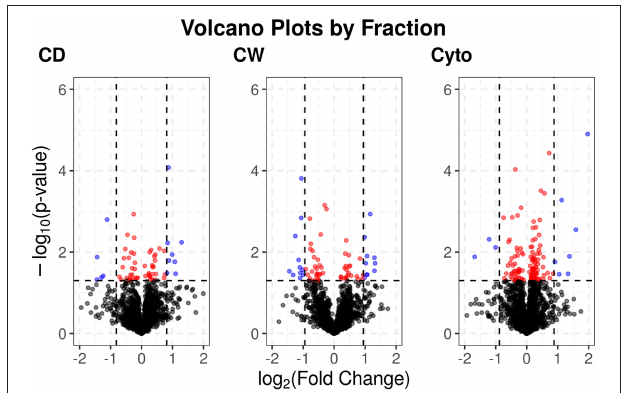
FIGURE 3 | Volcano plots for SL proteins by cellular fraction. Proteins dysregulated upon rifampicin treatment. Red and blue dots indicate proteins with p < 0.05. Blue dots have log 2 fold changes > 2 times the SD for fold changes in that cellular